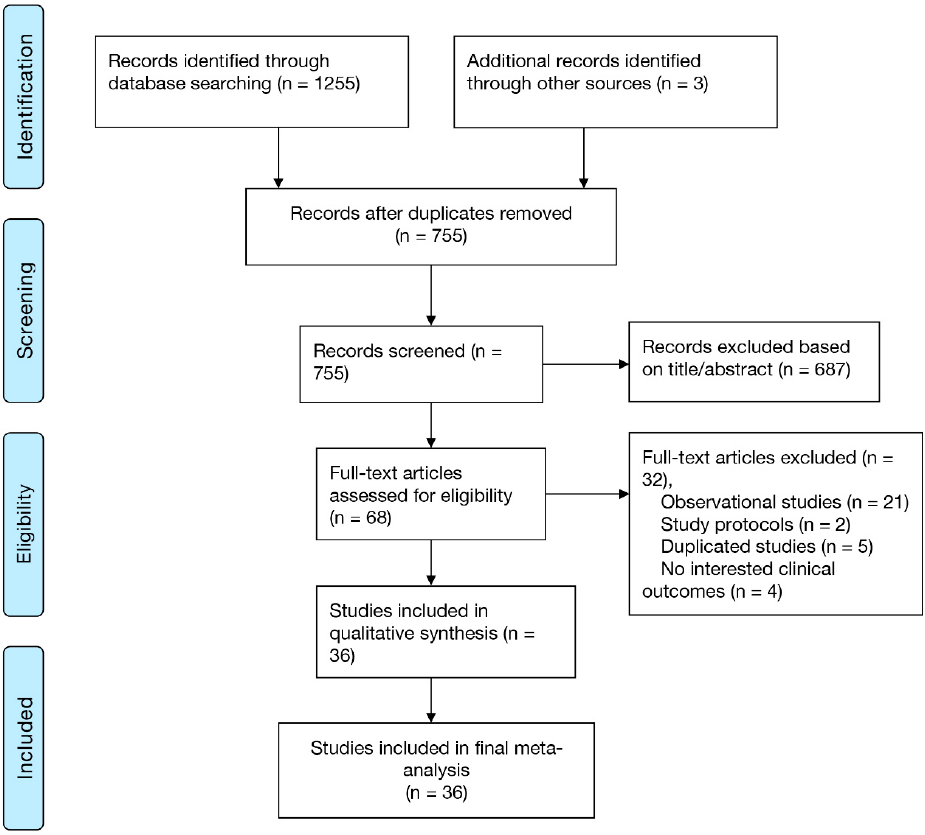
Figure 1. PRISMA diagram for study inclusion. CAG: coronary angiography; FFR: fractional flow reserve; iFR: instantaneous wave-free ratio; IVUS: intravascular ultrasound; OCT: optical coherence tomography; OFDI: optical frequency domain imaging.